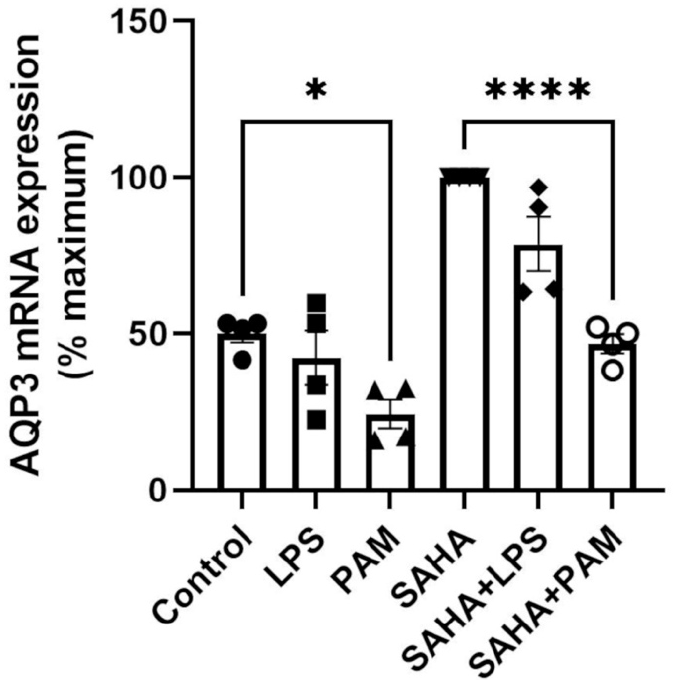
Figure 2. TLR2 Activation Decreased AQP3 mRNA Expression. Mouse keratinocytes were treated with 0 and 2.0 µ g/mL LPS or 2.5 µ g/mL PAM, in the presence or absence of 1 µ M SAHA, for 24 h. mRNA expression of AQP3 was monitored by quantitative RT-PCR. The data are shown as % maximal response and represent the means ± SEM from at least four independent experiments; symbols represent individual experiments. * p < 0.05 and **** p < 0.0001 versus the control value.